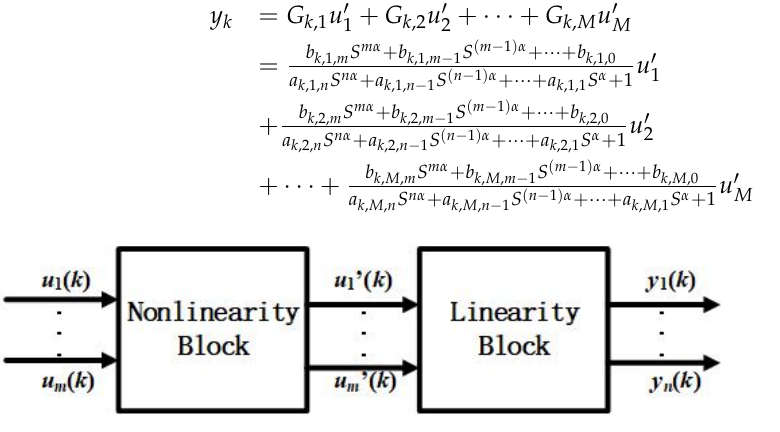
Figure 4. MIMO Hammerstein